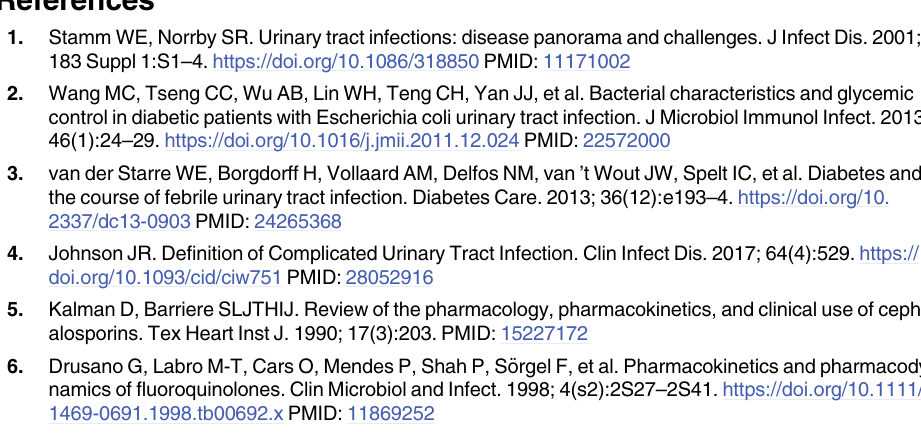
S2 Table. The proportion of patients who received appropriate empiric therapy according to the antimicrobial susceptibility testing report. S3 Table. Baseline characteristics and outcome of 126 patients after 1:1 propensity score matching. S4 Table. Cefazolin vs. non-cefazolin baseline. S5 Table. Cefazolin vs. non-cefazolin primary